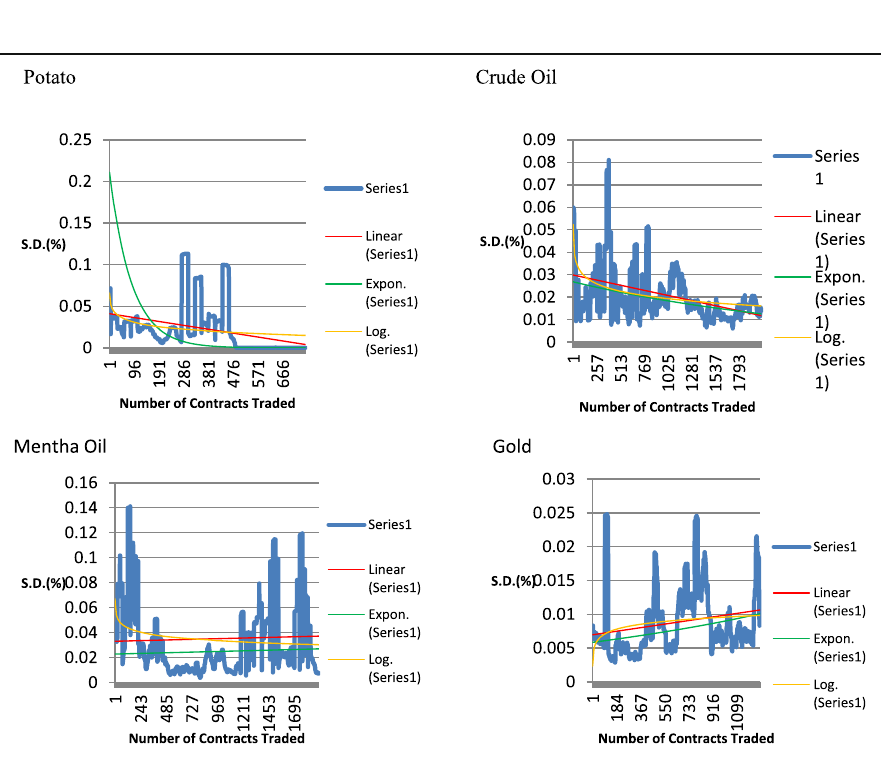
Fig. 3 Trends based on rolling standard deviation for 3 (far) month